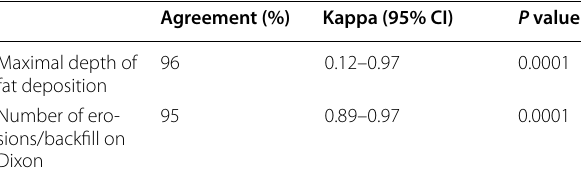
Table 6 Interobserver